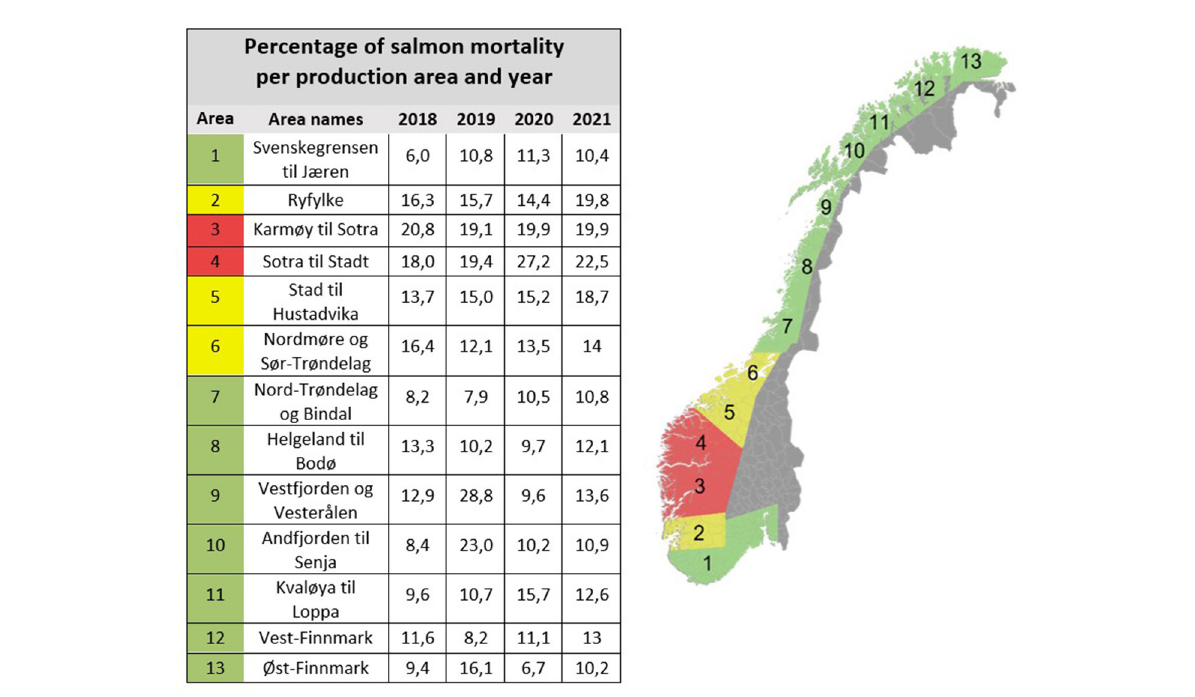
FIGURE1 Map with production zones in traffic light colors and mortality rates in the Norwegian salmon farming industry. Credits: own elaboration with information taken from Veterinærinstituttet 2022: